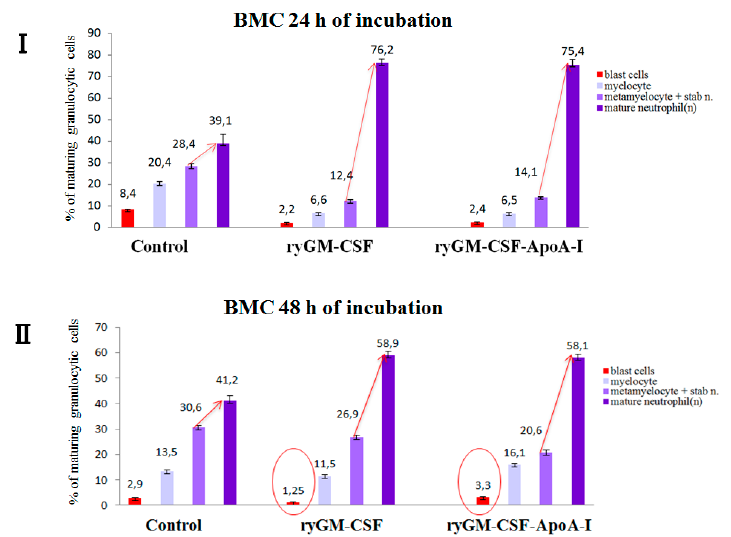
Figure 8. Dynamics of changes in cells content of the granulocytic series under the influence of